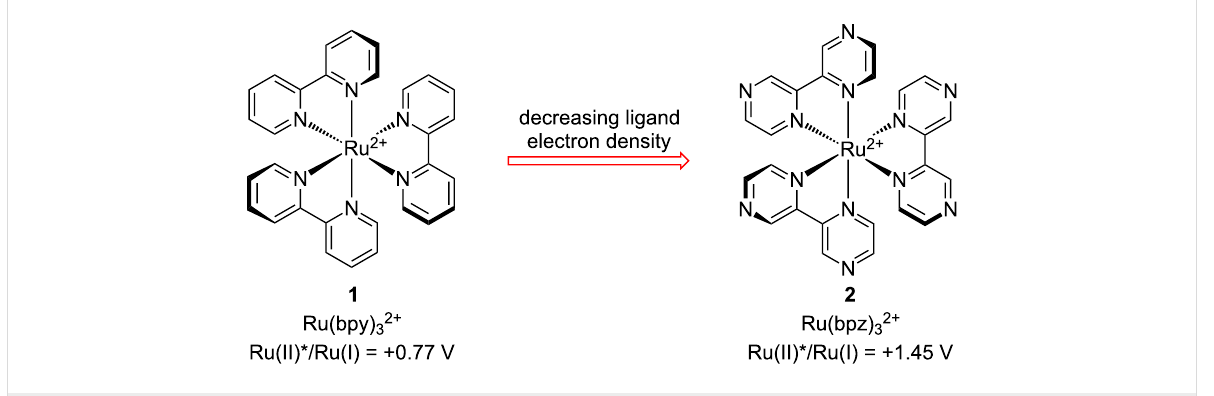
Figure 1: Influence of ligand structure on photoredox behavior.